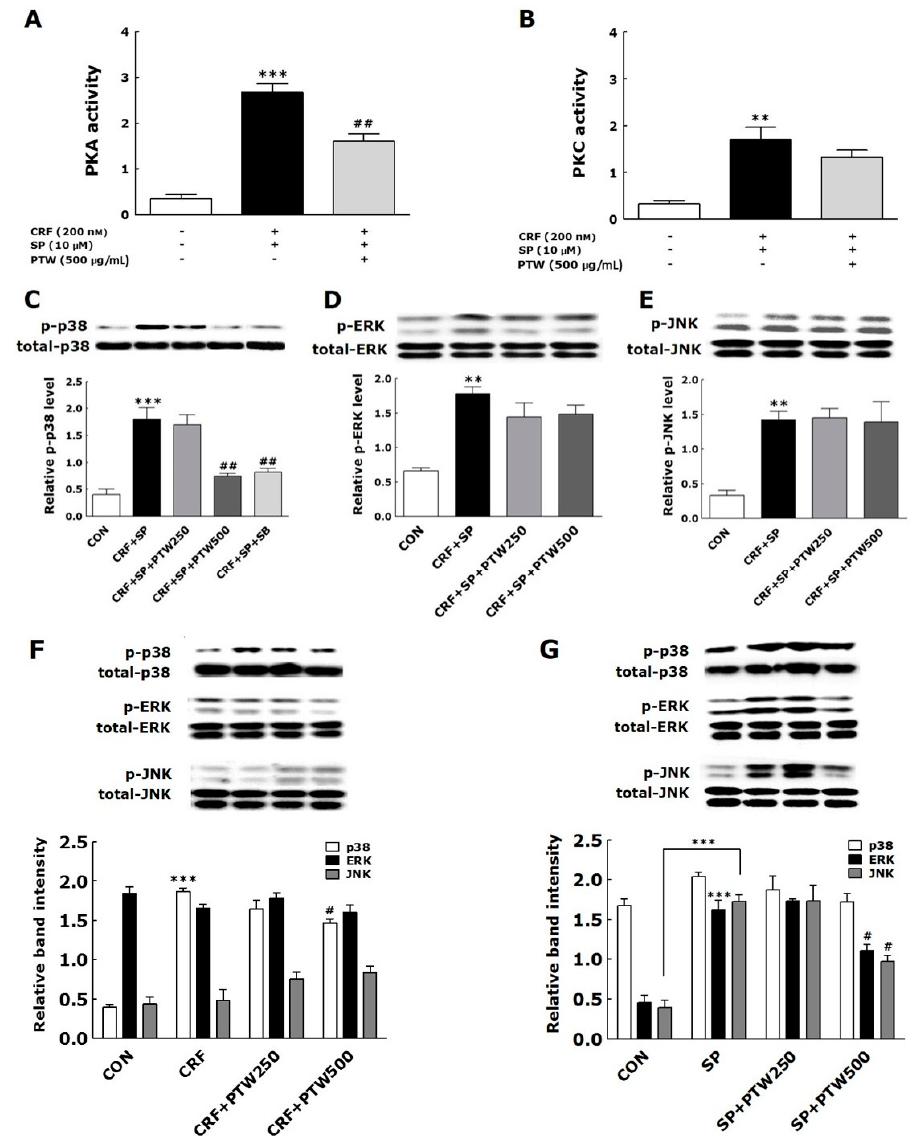
Figure 4. Effect of PTW extract (250 or 500 µg/mL) on PKA ( A ) and PKC ( B ) activities, phosphorylation of p38 ( C ), ERK ( D ) and JNK ( E ) MAPKs in HMC-1 cells previously stimulated by sequential treatments with SP and CRF. PTW efficacy on phosphorylation of MAPKs was also examined in HMC-1 cells stimulated by CRF ( F ) only or SP ( G ) only. CRF: corticotropin-releasing factor; SP: substance P; SB: SB203580; HMC: human mast cell; PTW: Polygala tenuifolia Willd.; PKC: protein kinase C; PKA: protein kinase A; ERK: extracellular signal-regulated kinase; JNK: c-Jun N-terminal kinase; MAPK: mitogen-activated protein kinase. SB20358 (10 µ M), a p38 mitogen-activated protein kinase (MAPK) inhibitor, was used as a positive control of inhibiting p38 phosphorylation in HMC-1 cells. Plus (+) and minus ( − ) in the X-axis description of A and B indicate “treated” and “non-treated”, respectively. ** p < 0.01 and *** p < 0.001 vs. non-treated HMC-1 cells (CON); # p < 0.05 and ## p < 0.01 vs. CRF + SP-treated HMC-1